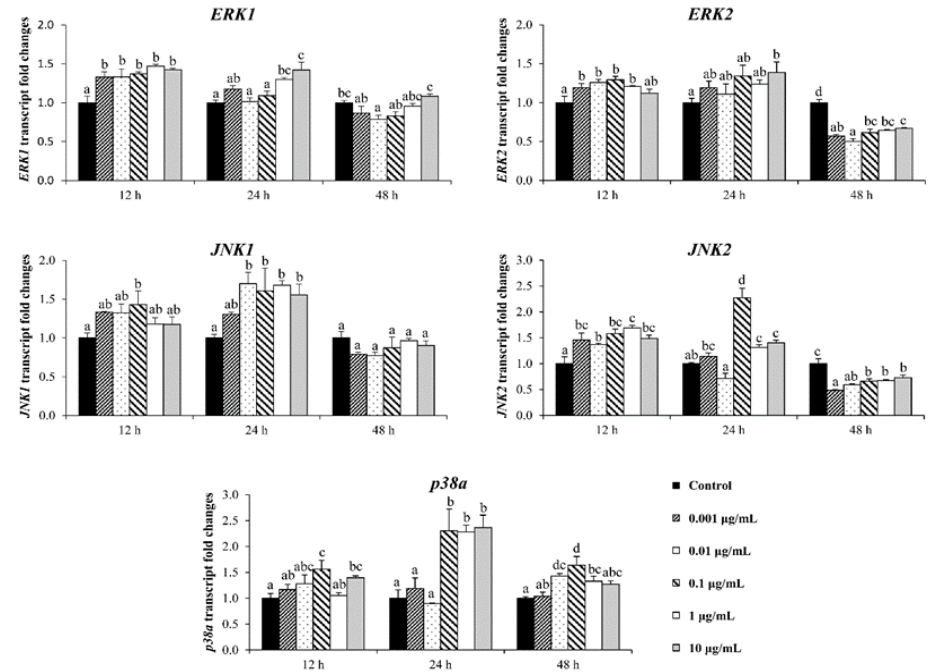
Figure 6. Analysis of mRNA level expressions of MAPK pathway genes ERK1 , ERK2 , JNK1 , JNK2, and p38α by quantitative real-time PCR. MC3T3-E1 cells were treated with Ps -GOS in various concentrations for 24, 48, and 72 h. The data were obtained from three independent experiments in four replicates as mean ± SEM. The data in columns with different letters in each group were significantly different at p < 0.05.